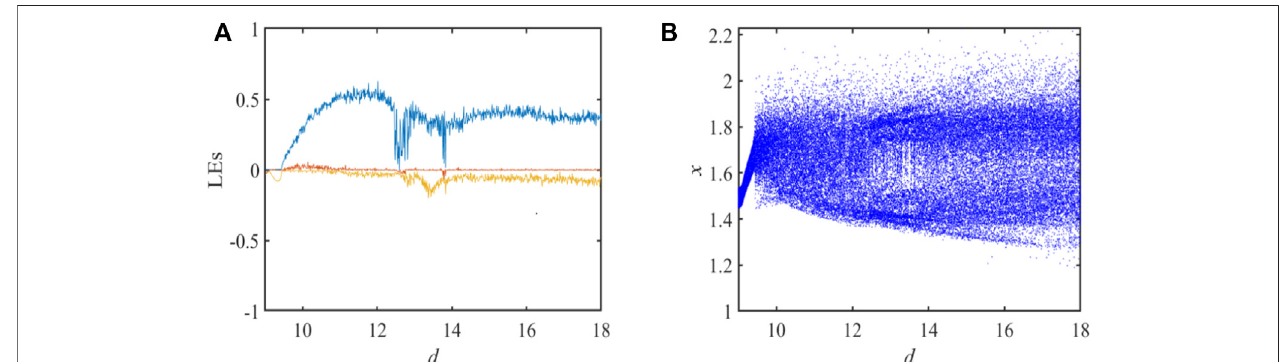
FIGURE 5 | (A) LEs (B) bifurcation diagram.